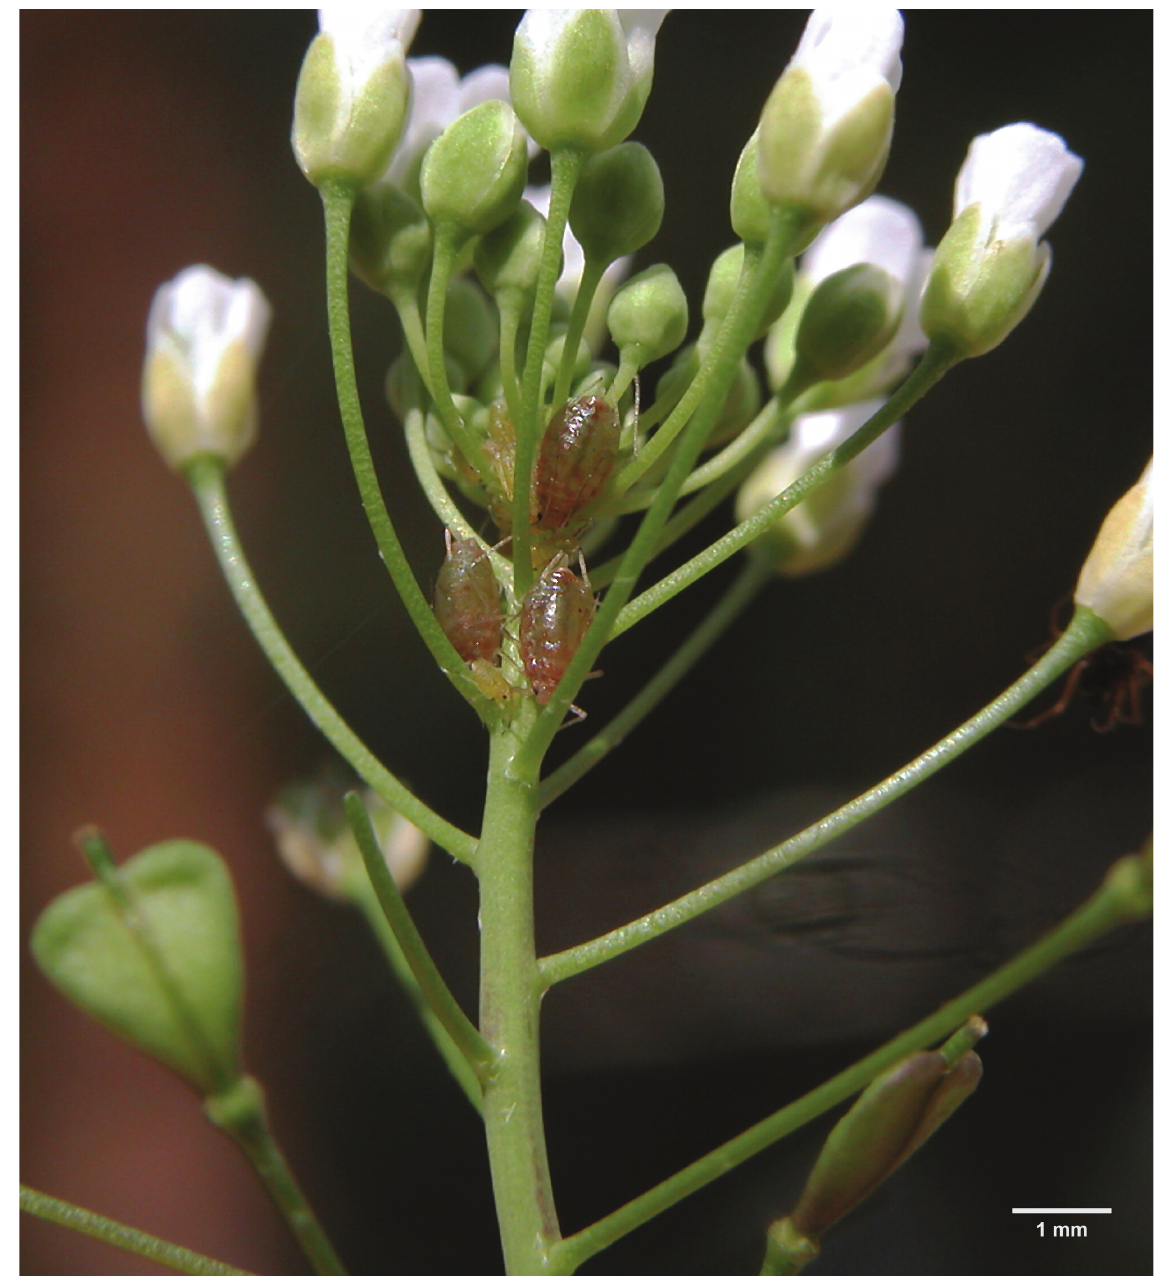
Fig. 36. Myzus persicae (Sulzer, 1776). Apterae and juveniles on Capsella